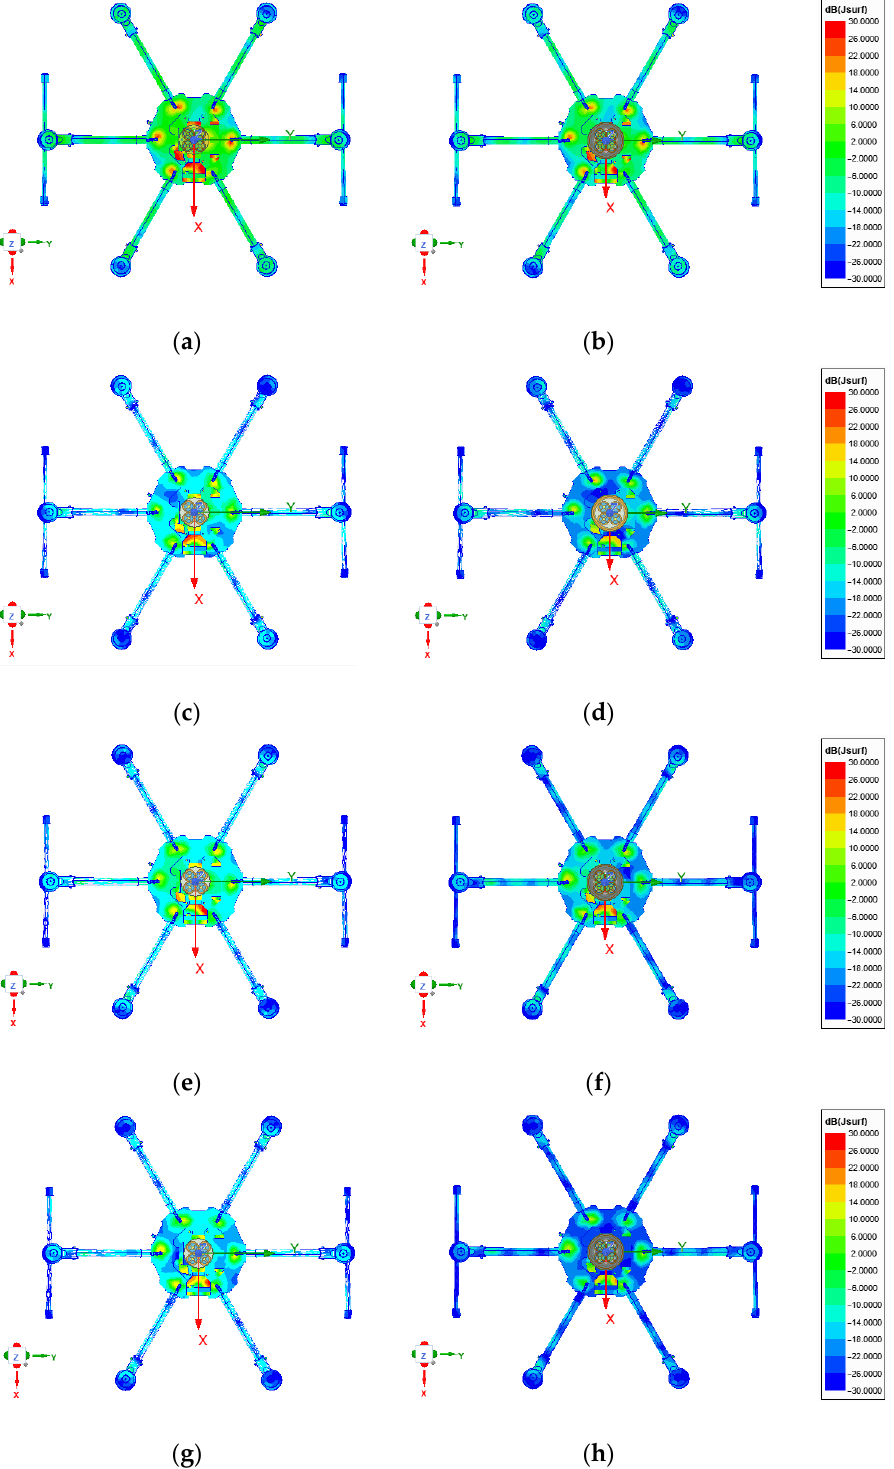
Figure 7. Simulated surface currents at the E5a and E1 center frequencies on a hex-rotor UAV for the miniaturized GNSS array without (left) and with (right) vertical choke rings and different installation heights. ( a ) L5/E5a, h = 50 mm wo. vertical choke; ( b ) L5/E5a, h = 50 mm w. vertical choke; ( c ) L5/E5a, h = 110 mm wo. vertical choke; ( d ) L5/E5a, h = 110 mm w. vertical choke; ( e ) L1/E1, h = 50 mm wo. vertical choke; ( f ) L1/E1, h = 50 mm w. vertical choke; ( g ) L1/E1, h = 110 mm wo. vertical choke; ( h ) L1/E1, h = 110mm w. vertical choke.